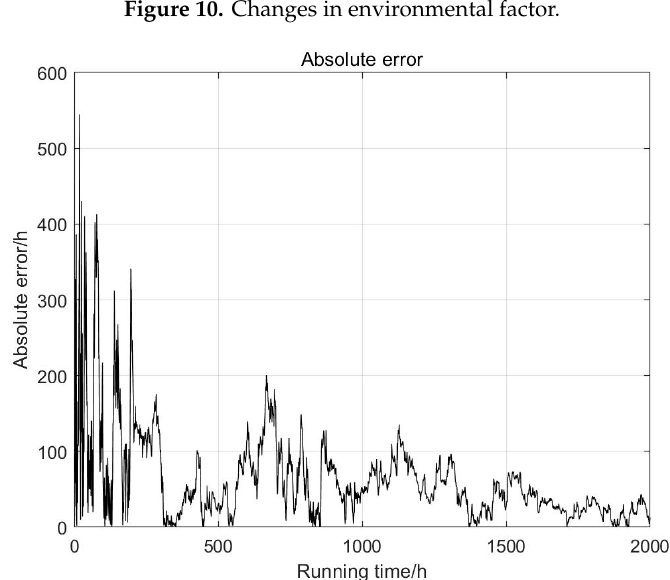
Figure 11. Changes in absolute error.